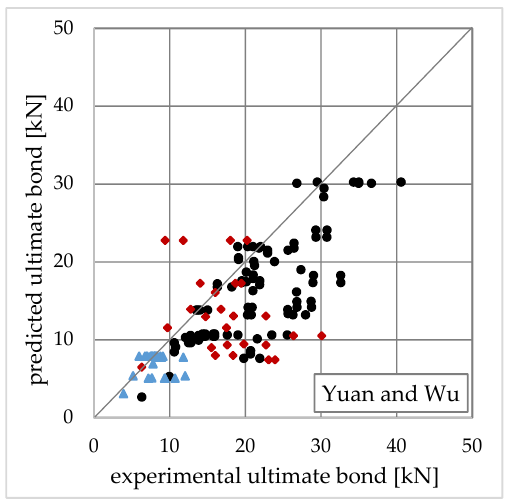
Figure 7. Test vs. predicted bond force using the Neubauer and Rostasy model [19].